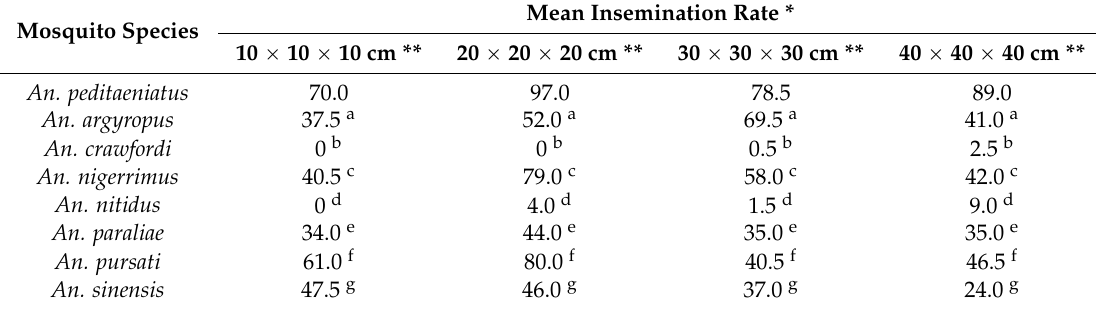
Table 2. Insemination rates of the eight species of the Hyrcanus Group using various cage sizes (10, 20, 30 and 40 cubic cm cages) at DRS of 7.2.